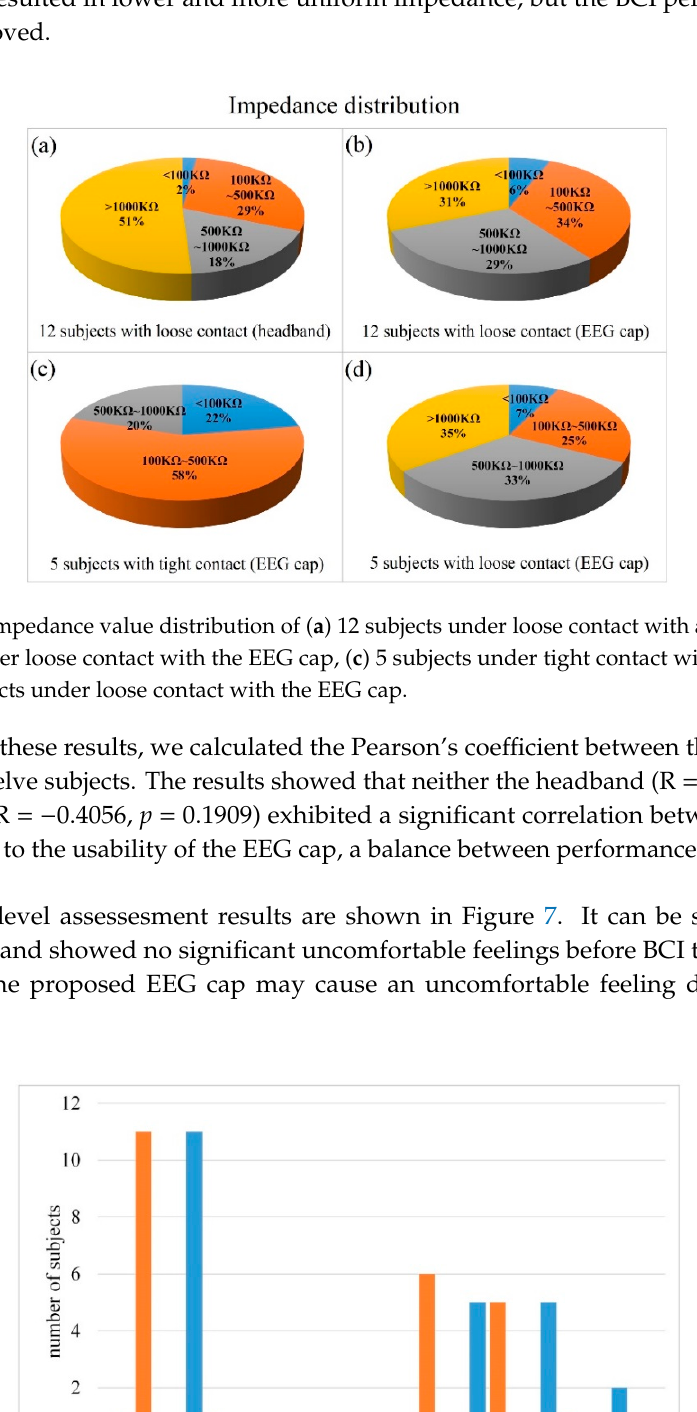
Figure 7. Comfort assessment of the EEG cap and headband before and after the experiment. Level 1 represents very comfortable, 2 represents comfortable, 3 represents uncomfortable, and 4 represents uncomfortable with little pain.